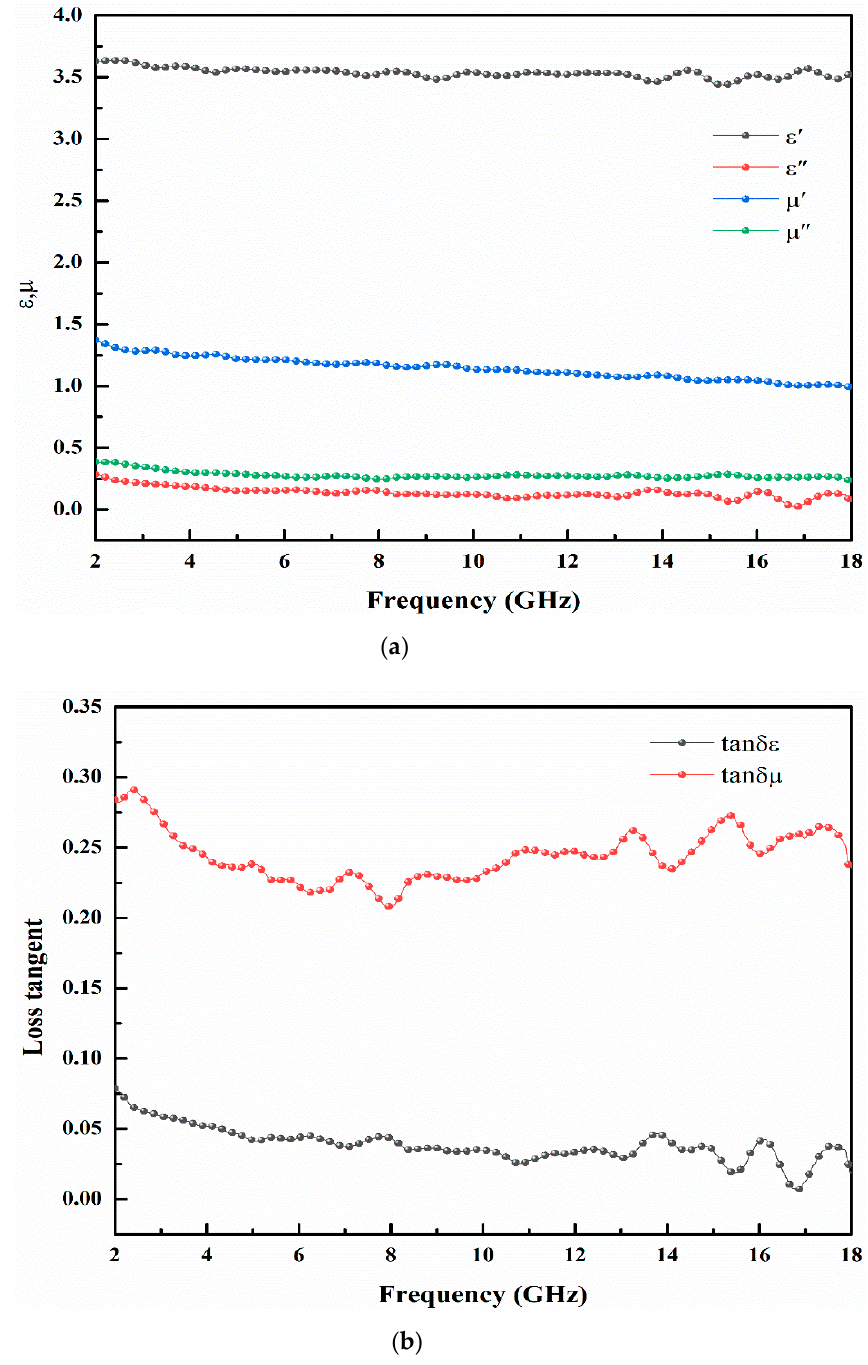
Figure 6. ( a ) EM parameters of CB/CIP particles; ( b ) loss tangent of CB/CIP particles. As shown in Figure 7, the S-band refers to the electromagnetic (EM) wave frequency range between 2 GHz and 4 GHz. The C-band refers to the EM wave segment with a frequency between 4 GHz and 8 GHz. The X-band refers to the EM wave segment with a frequency between 8 GHz and 12 GHz. The Ku-band refers to the EM wave segment with frequencies between 12 GHz and 18 GHz. The S0 reached the RL min of − 11.4 dB at a Ku-band (15.66 GHz). The S1 reached the RL − 15.06 dB at Ku-band min of (15.48 GHz). Therefore, we found that CB/CIP can improve the absorbing loss capacity of the whole